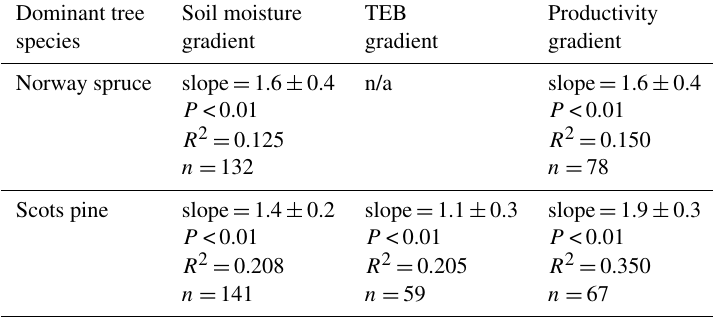
Table 4. Evaluation of adjusted nutrient availability metric 1 for selected nutrient availability gradients in Sweden (Fig. S2). Statistics indicate the relationship between productivity (mean annual increment – m 3 ha − 1 yr − 1 ) and the metric. For (near) significant variables (i.e., P < 0 . 10), parameter estimates ± s.e.m. and the proportion of variation explained ( R 2 ) are given. For Norway spruce, no TEB gradient without substantial variation in climate was found, so that only for Scots pine was there a gradient in TEB. Abbreviations: TEB: total exchangeable bases. Error bars represent the s.e.m.